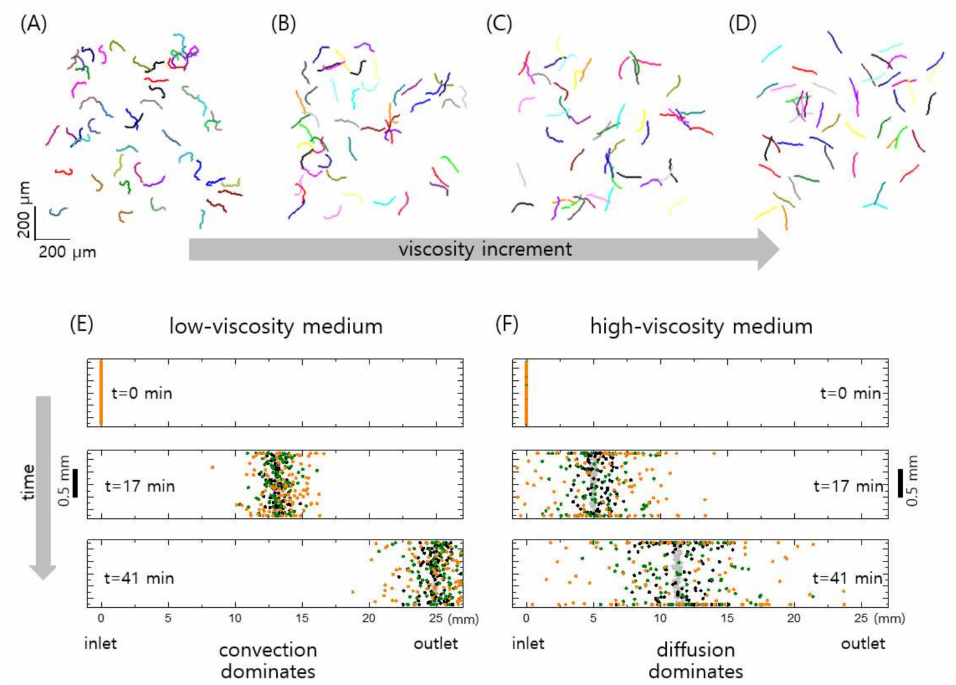
Figure 6. Theoretical description of sperm cell dynamics. ( A – D ) A sperm cell can be described as an active matter, self- propelled particle that is propelled with a speed of v 0 subject to rotational diffusion (see the text for detail). Trajectories over 10 s for 50 randomly distributed sperm with v 0 = 15 µ m/s are shown for different rotational diffusion coefficients D r = 0.2 ( A ), 0.1 ( B ), 0.05 ( C ), and 0.02 rad/s ( D ). ( E , F ) Spatial distributions of 100 sperm with speed v 0 = 0.5 (grey dots), 1 (black dots), 5 (green dots), and 15 µ m/s (orange dots) under shear flow in the channel filled with low-viscosity ( D r = 0.1 rad/s) and high-viscosity ( D r = 0.02 rad/s) media at different times t = 0, 17, and 41